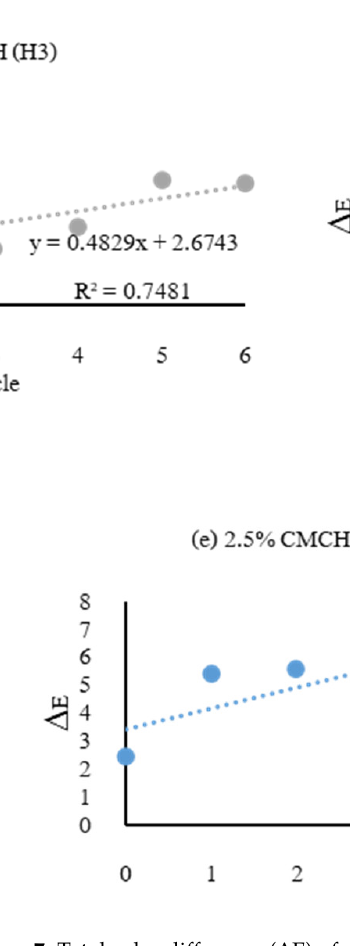
Figure 7. Total color difference (∆E) of deodorant cream adding ( a ) 0.5%, ( b ) 1.0 %, ( c ) 1.5%, ( d ) 2.0% and ( e ) 2.5% ( w / v ) H-CMCH; heating/cooling cycle for up to 6 cycles.